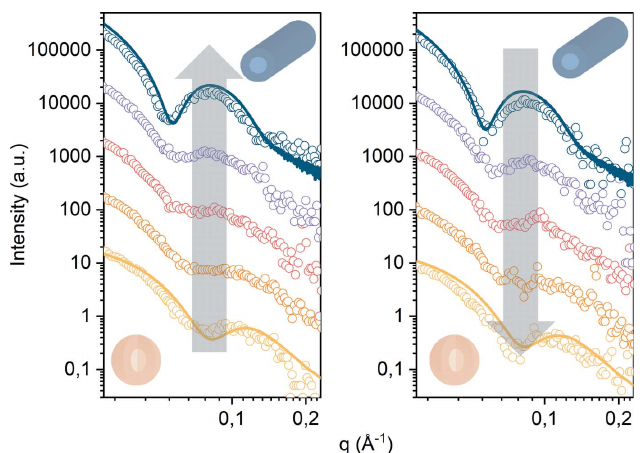
Figure 5 Reversible exchange of ionic buffer conditions. In-house SAXS signal of a charged lamellar phase (Soy PC doped with 5 wt% DOTAP) exhibits the shrinking and subsequent swelling of the intermembrane distance in response to increasing and decreasing salt concentrations. Black lines indicate fits of the data using the modified Caille´ theory (MCT) combined with a Gaussian electron density representation, as proposed by Pabst et al. (2000). The sample was equilibrated for seven